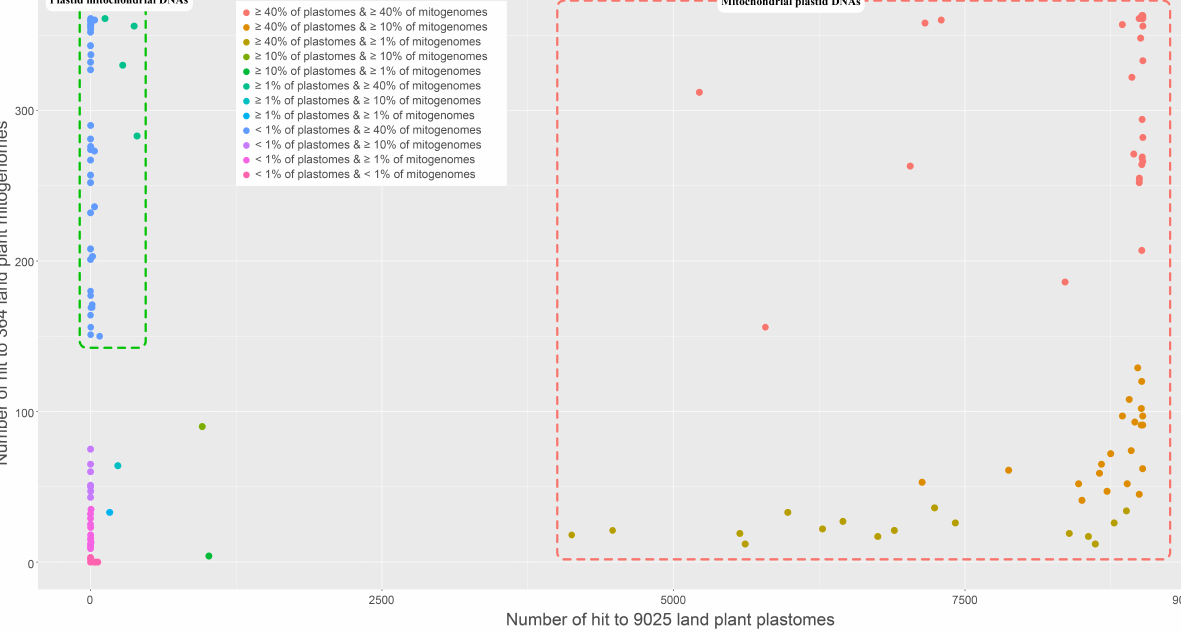
Figure 5. BLAST results for searches against 9025 plastomes (X axis) and 364 mitogenomes (Y axis) of terrestrial plants. Different-colored dots denote the difference in the percentage matches for